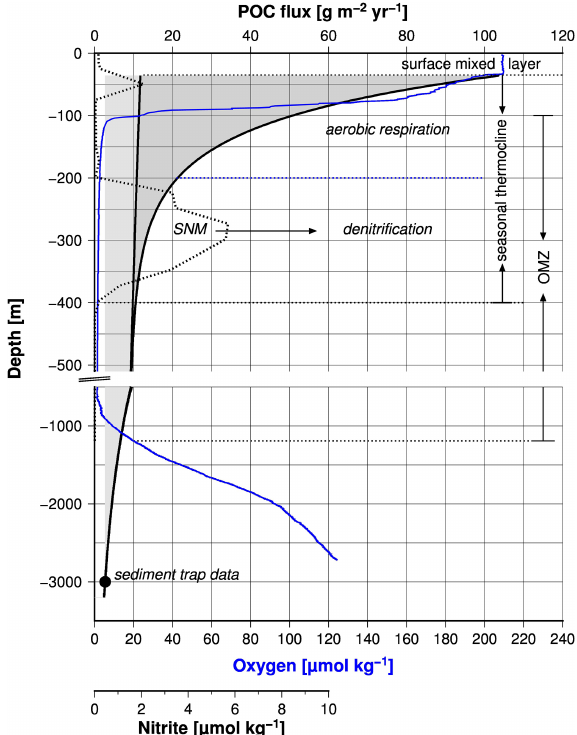
Figure 8. Fluxes of protected and free particulate organic carbon versus water depth (black line). The fluxes were calculated accord- ing to the equation introduced by Armstrong et al. (2002) and data measured by a sediment trap in the central Arabian Sea. The black circle shows the long-term mean organic carbon fluxes measured by sediment traps in the central Arabian Sea. The blue and broken black lines indicate concentrations of dissolved oxygen and nitrite measured during the cruise M74 in 2007 in the central Arabian Sea (Station 450). Rixen et al. (2014) provide further information about the sediment trap study and the RV Meteor cruise M74. The bro- ken horizontal lines mark the depth of the OMZ, the surface mixed layer, and the seasonal thermocline. The latter is subdivided into an aerobic upper and a lower anaerobic part. SNM means secondary nitrite